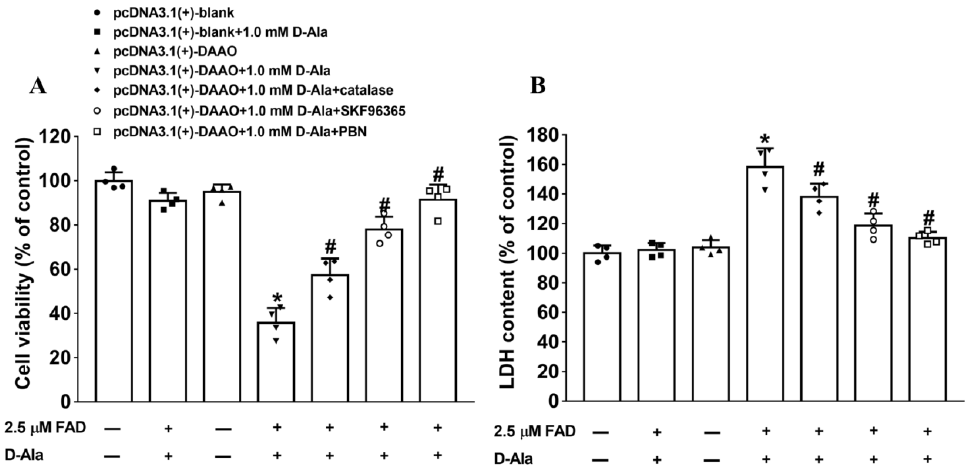
Figure 6. DAAO overexpression inhibits cell activity and induces cytotoxicity. ( A ) Cell activity was measured with a CCK-8 assay kit. ( B ) Cytotoxicity was assessed based on an LDH leakage assay. DAAO inhibitor SUN (50 μM), nonselective TRP calcium channel antagonist SKF96365 (10 μM), and active oxygen scavenger PBN (10 μM) were applied to evaluate whether TRP calcium channels and H 2 O 2 are involved in DAAO-induced neuronal apoptosis. * denotes statistical significance ( p < 0.05) compared with pcDNA3.1(+)-blank+1.0 mM D-Ala group; # denotes significant difference from model group treated with saline ( p < 0.05) calculated by one-way ANOVA and post hoc Student–Newman–Keuls test.